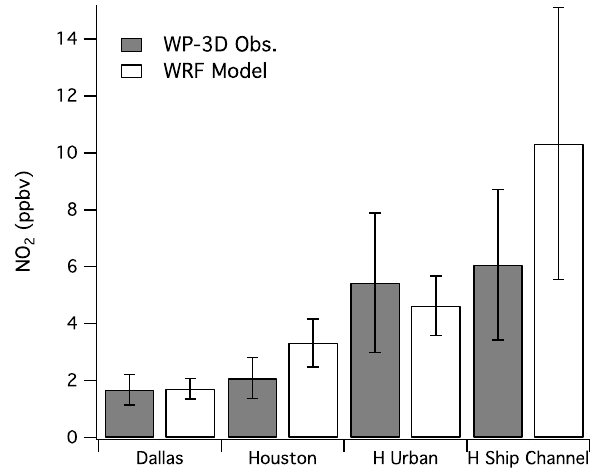
Fig. 10. WP-3D and model NO 2 averaged for Dallas, Houston, Houston urban, and Houston Ship Channel sources. Filled (unfilled) bar represents WP-3D (WRF-Chem model) NO 2 . Temporal variability (standard deviation) of columns is shown as error bars. 2 (6) day flight data are used for Dallas (Houston). “Dallas” and “Houston” boxes are the same as the source boxes for satellite-model comparison (Table 4). “H Urban” means the average over the flight segments influenced by urban sources in Houston. “H Ship Channel” denotes the average over the flight segments influenced by industrial and commercial marine vessel sources in the Houston Ship Channel region. Houston Ship Channel flights are defined as in Figs. 9 for 6 daytime flights. The number of samples is 2 (284), 6 (2595), 6 (119), and 6 (142) days (number of the model grids) for Dallas, Houston, Houston Urban area, and Houston Ship Channel area, respectively.